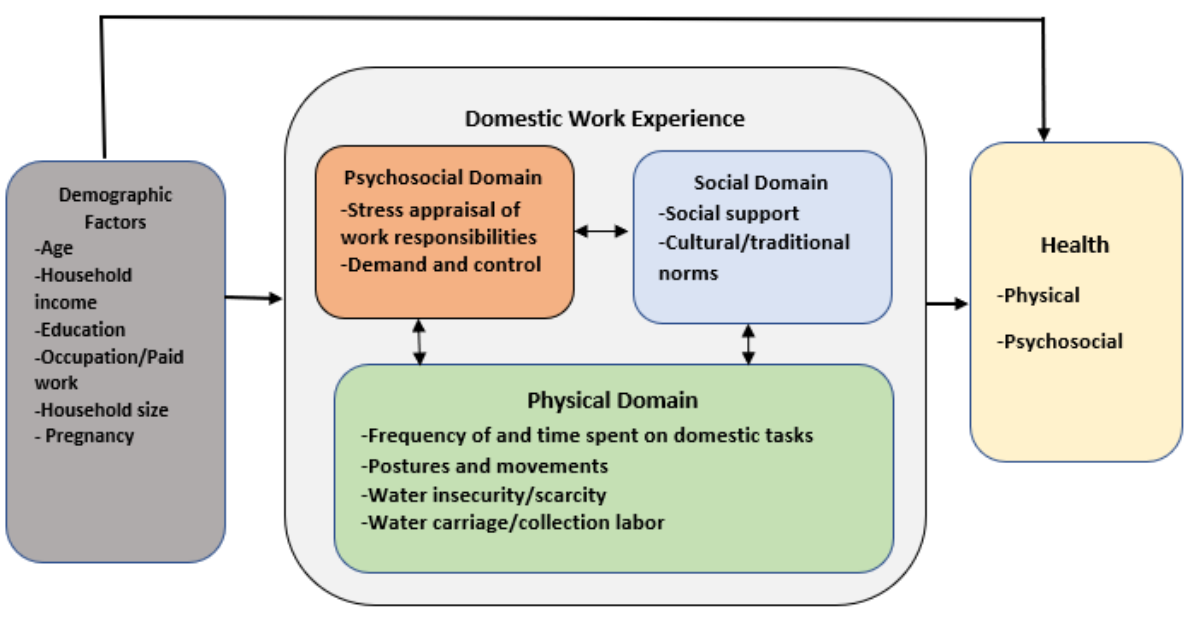
Figure 1. The Domestic Work Experience Model .